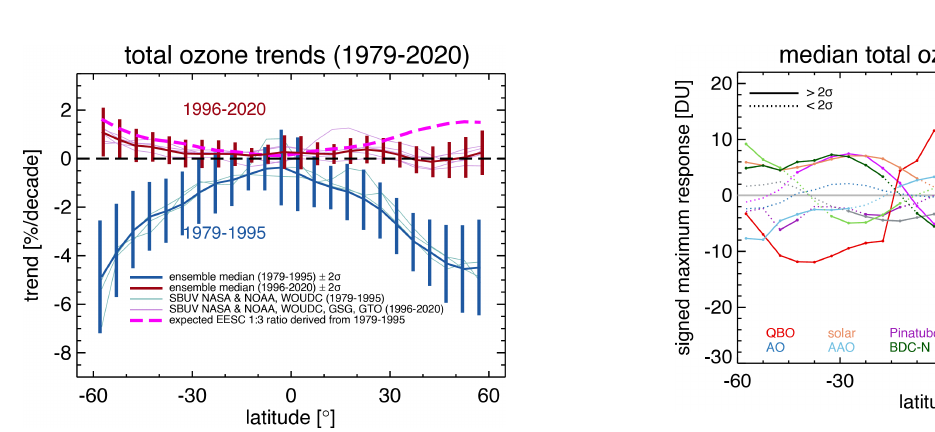
Figure 5. Signed maximum time series contribution from various terms in the full MLR equation applied to the median of the five merged total ozone datasets. Solid line indicates values of fit co- efficients that are larger than their 2 σ uncertainty. The sign of the BDCs proxy time series is reversed, so that in both hemispheres positive BDC term values correspond to enhanced Brewer–Dobson circulation. Negative values correspond to an anti-correlation of the ozone response to the proxy. For instance, positive solar contribu- tions mean high solar activity, which leads to more ozone.